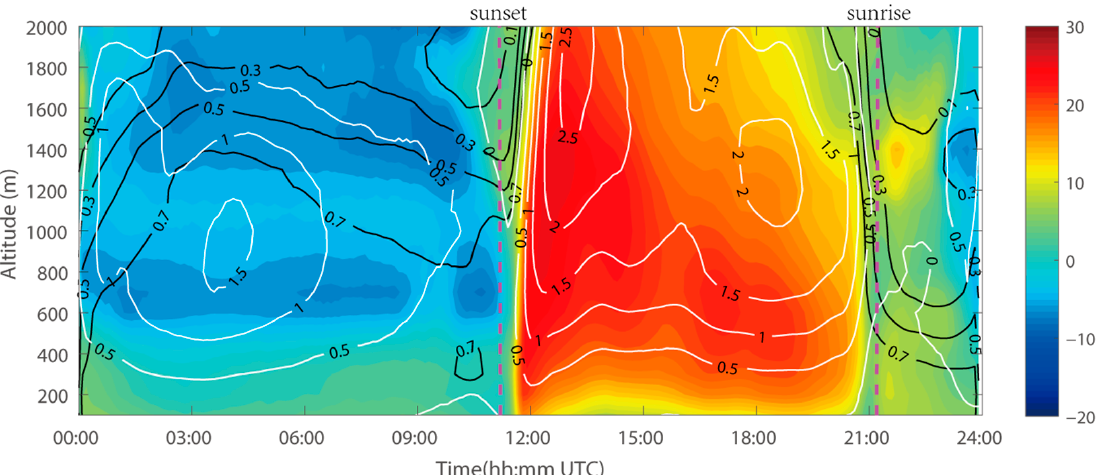
Figure 9. Time–height cross-section of radar products for 24 h from the CINRAD/SA at Daxing, Beijing, 2 May 2021. The fill color is Z (unit: dBZ); the black isopleths are valid data proportions; and the white isopleths are Z DR (unit: dB). The times of sunset and sunrise were 11:08 and 21:13, UTC, respectively.